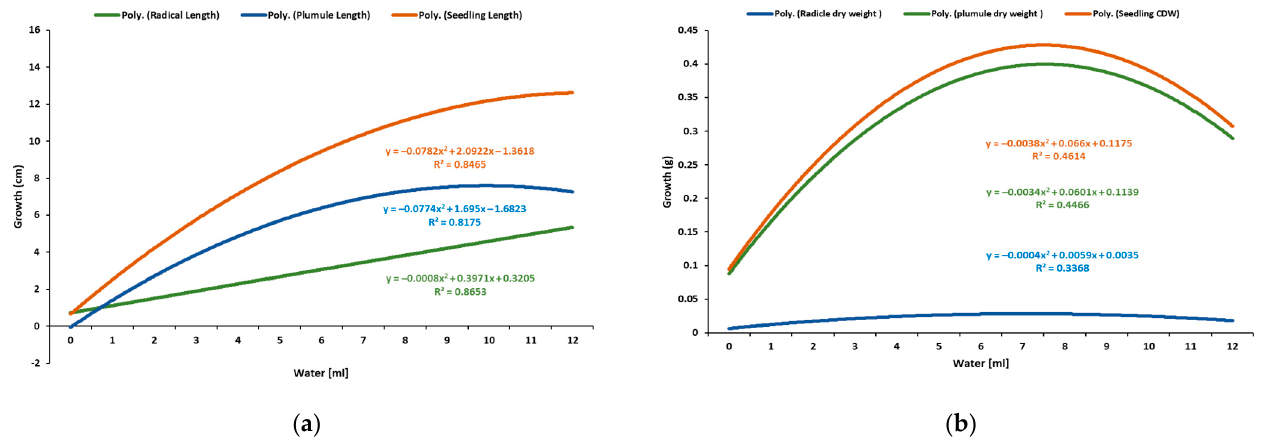
Figure 6. The effect of water quantity on seedlings, shoots, and roots. ( a ) Growth in relation to varied amounts of water at 1 mL intervals. ( b ) Dry weight accumulation vs. various quantities of water at 1 mL intervals.